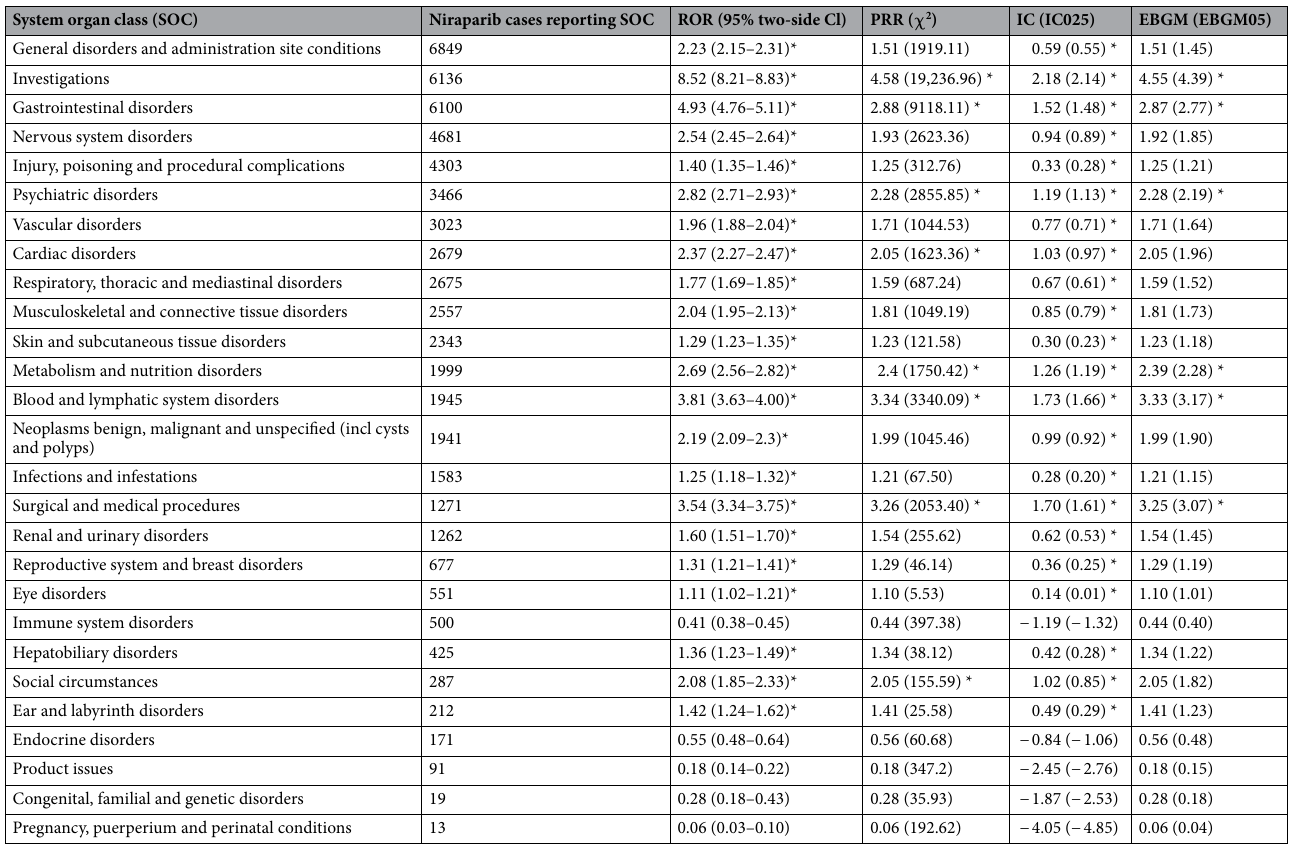
Table 2. Signal strength of reports of niraparib at the System Organ Class (SOC) level in FAERS database. *Indicates statistically significant signals in algorithm. ROR reporting odds ratio; CI confidence interval; PRR proportional reporting ratio; χ 2 , chi-squared; IC information component; IC025 the lower limit of 95% CI of the IC; EBGM empirical Bayesian geometric mean; EBGM05 , the lower limit of 95% CI of